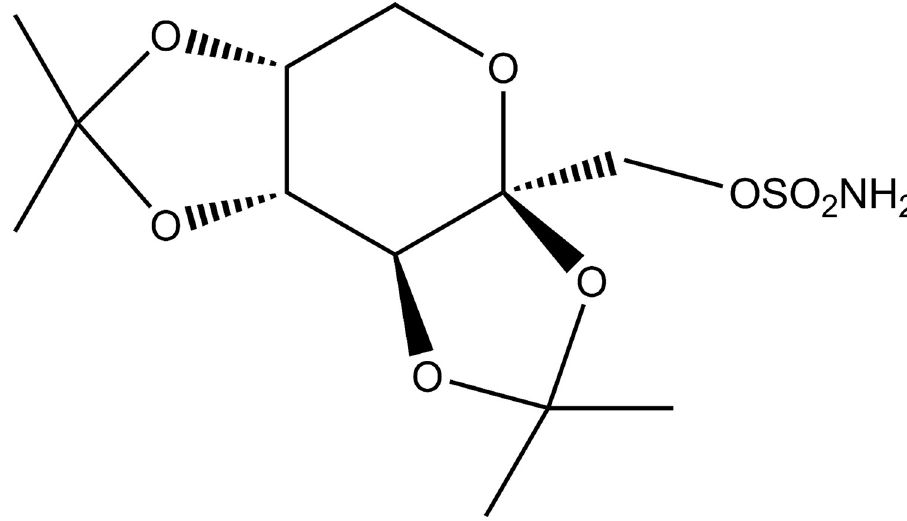
Fig 1. Chemical structural of